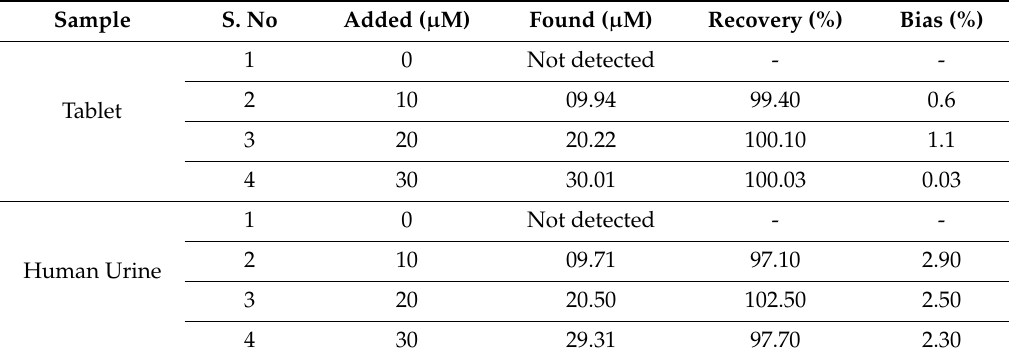
Table 2. Recovery profile of CPZ at N-CDs / Cu 2 O / Nf / GCE in real samples (n = 3).